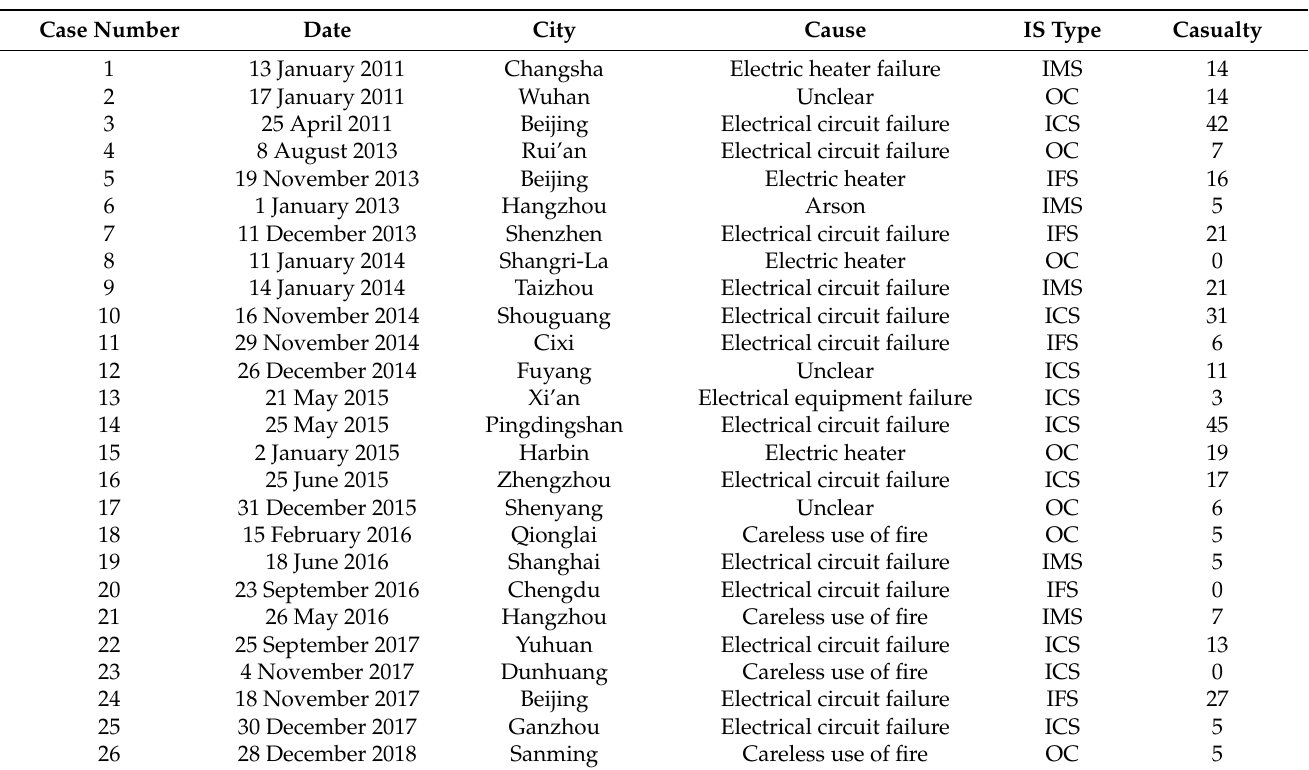
Table 1. The brief information of the fire cases in